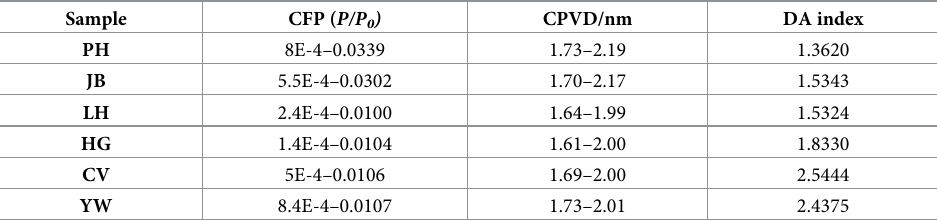
Table 3. Differential curve analysis of the adsorption isotherms of different rank coal